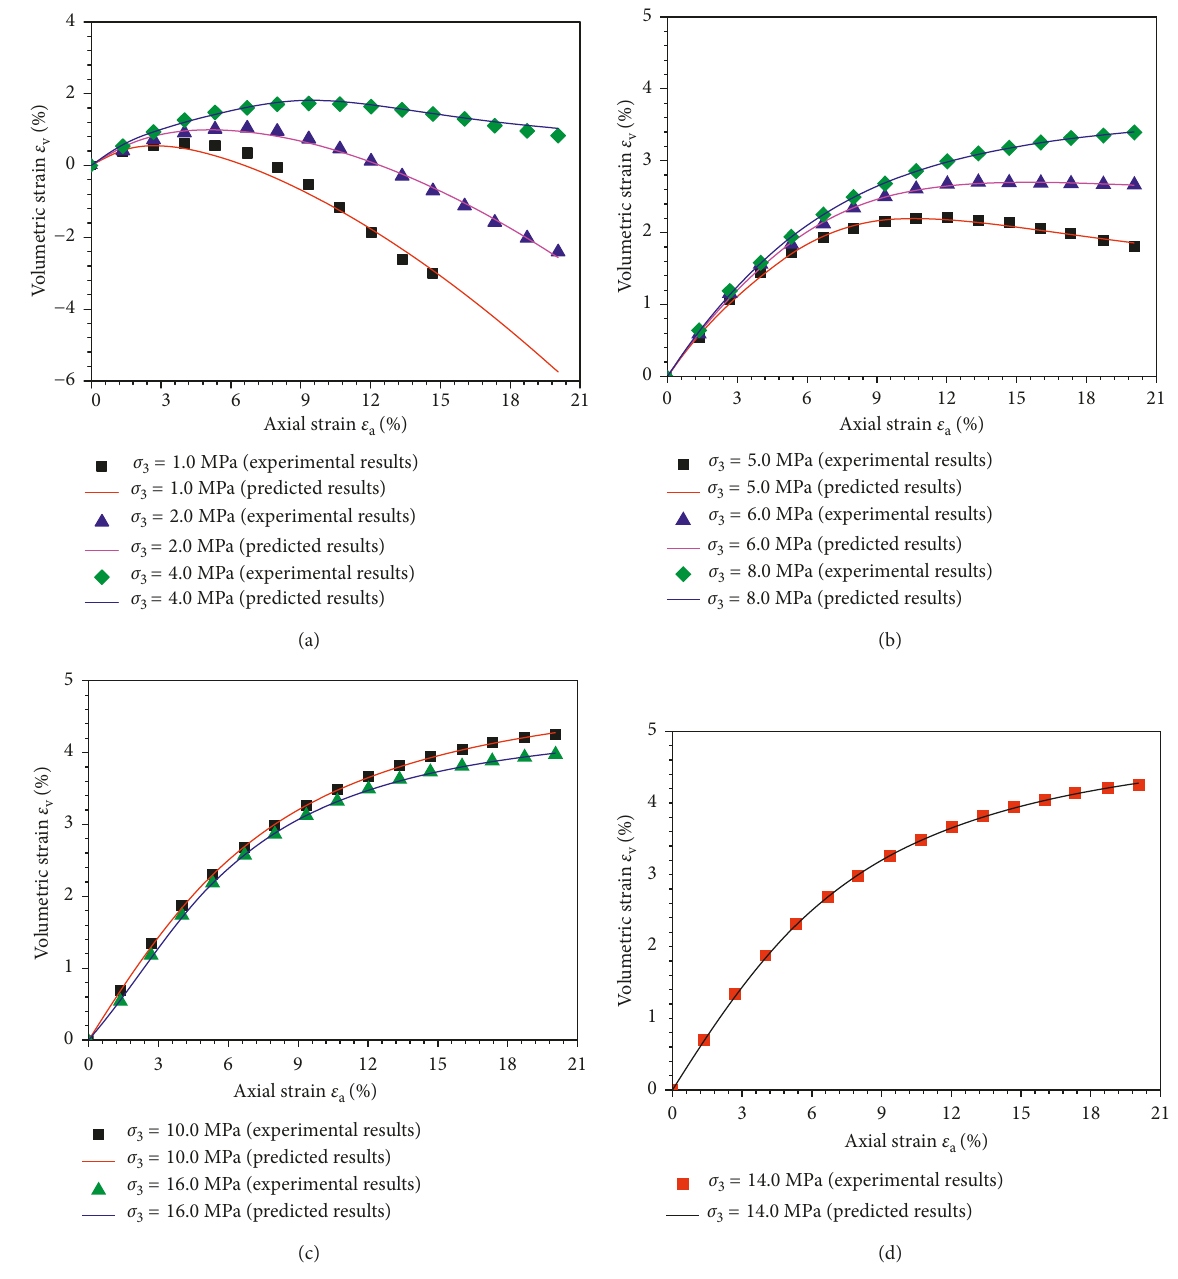
Figure 14: Comparisons between test data and predicted results of volumetric strain-axial strain under different confining